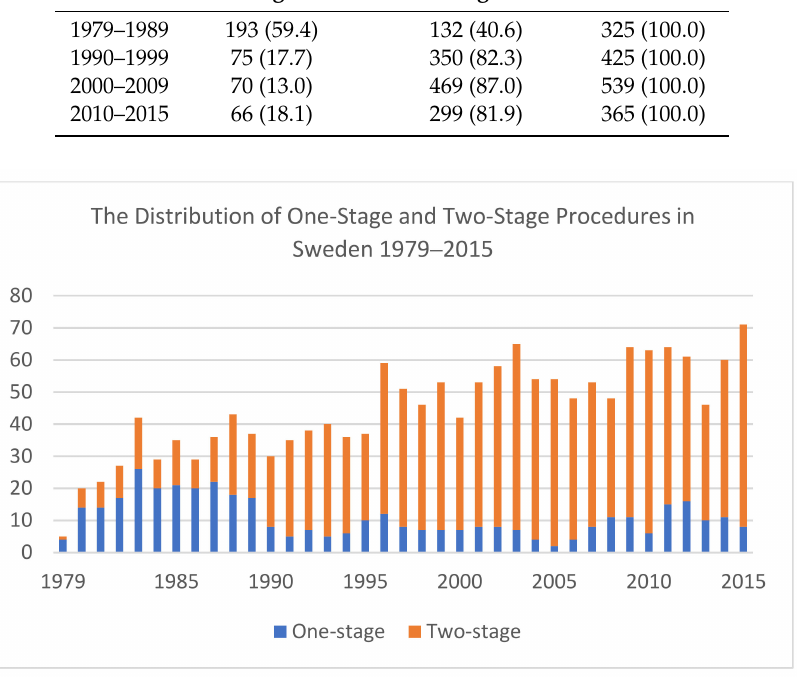
Figure 1. The distribution of one- and two-stage procedures in Sweden during 1979–2015.